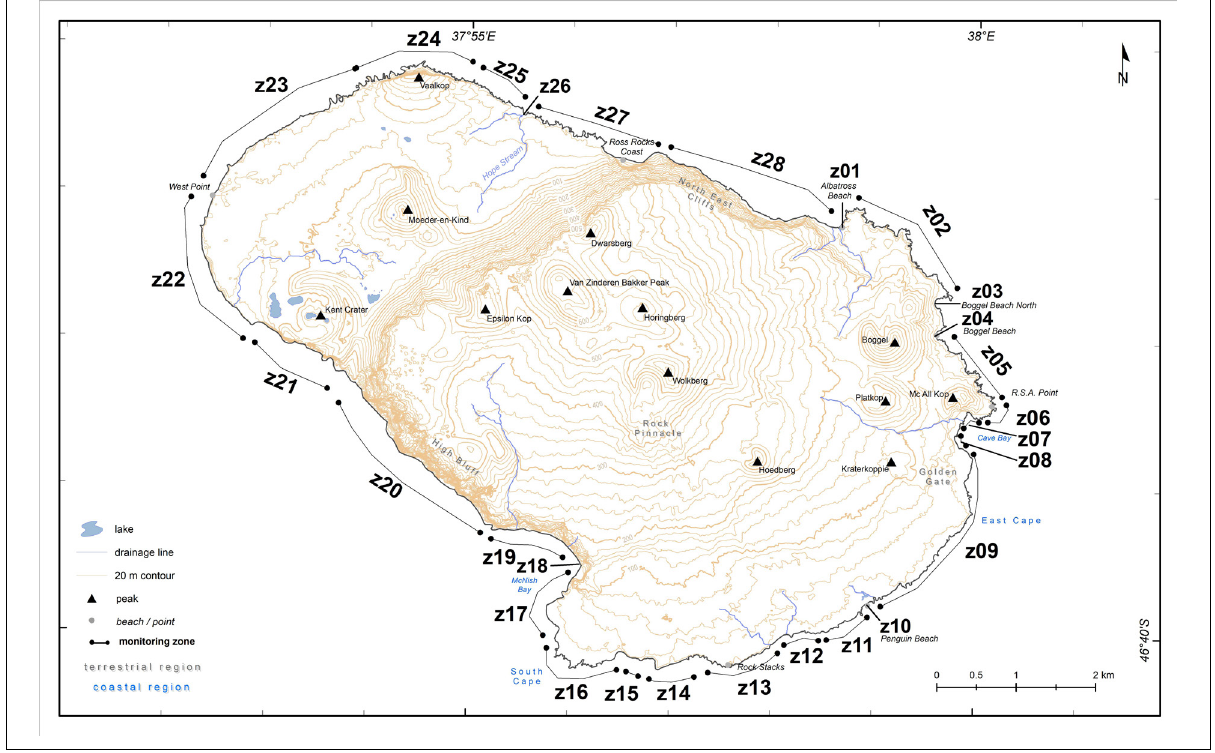
Figure 5: A preview of the map indicating codes of marine mammal monitoring beaches and zones used in research programmes at Prince Edward Island. The detailed code descriptions and coordinates can be found in Supplementary table 4 and the map is available to download from the open access dataset (see Table 1). Projection: Transverse Mercator